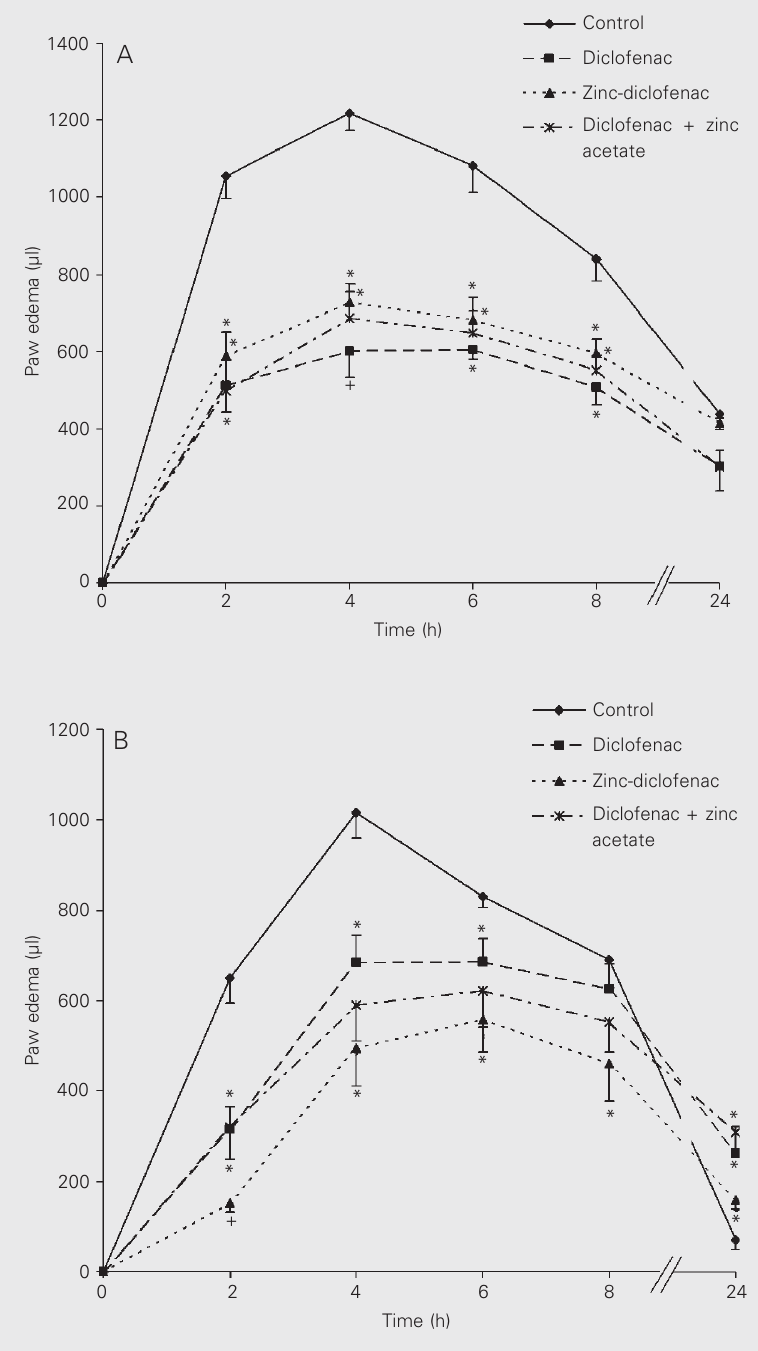
Figure 1. Effect of diclofenac, zinc-diclofenac and diclofenac plus zinc acetate on paw edema after per os and intraperitoneal administration. Diclofenac (10 mg/kg), zinc-diclofenac (11 mg/ kg), diclofenac (10 mg/kg) plus zinc acetate (3.35 mg/kg) or the corresponding volume of 0.5% carboxymethylcellulose (control) was administered per os (A) and intraperitoneally (B) 30 min before injection of 1% carrageenin into the subplantar region of the left hindpaw. Each value represents the mean ± SEM for 6 animals. *P < 0.05 compared to control; + P < 0.05 compared to the group treated with zinc-diclofenac (ANOVA and Duncan